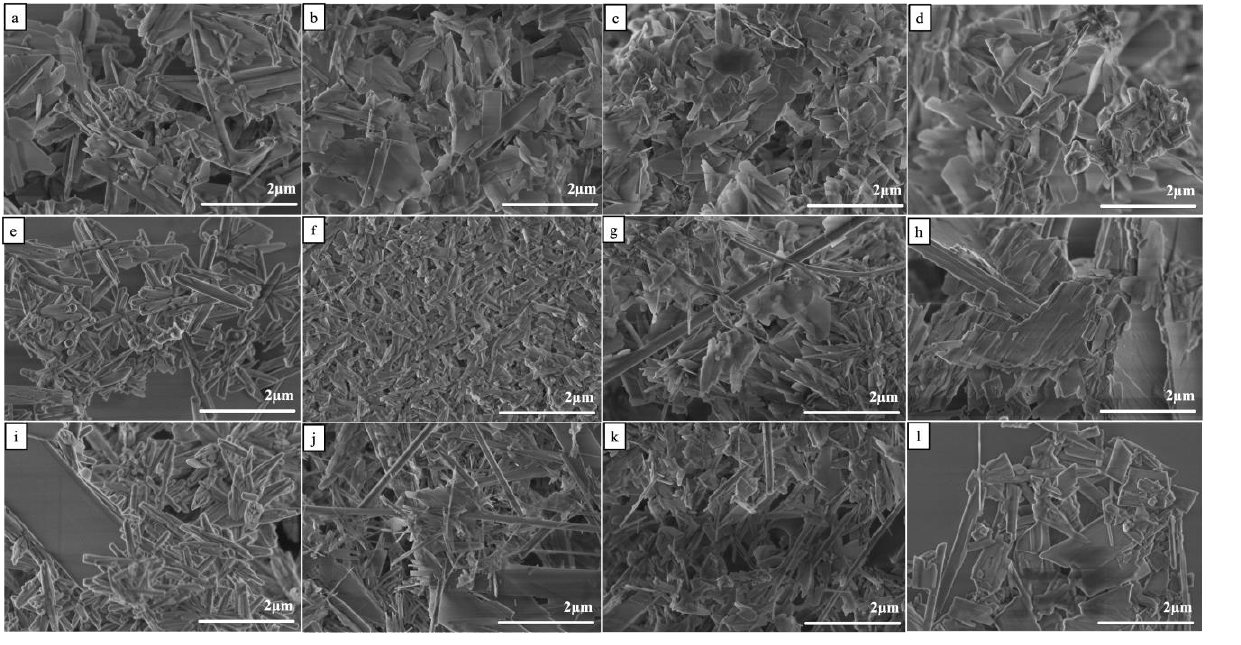
Figure 6. SEM micrographs of the samples after hydrothermal treatment SLS:005 ( a ), SLS:05 ( e ), and SLS:1 ( i ); Asp:005 ( b ), Asp:05 ( f ), and Asp:1 ( j ); DDDA:005 ( c ), DDDA:05 ( g ), and DDDA:1 ( k ); and Sa:005 ( d ), Sa:05 ( h ), and Sa:1 ( l ).